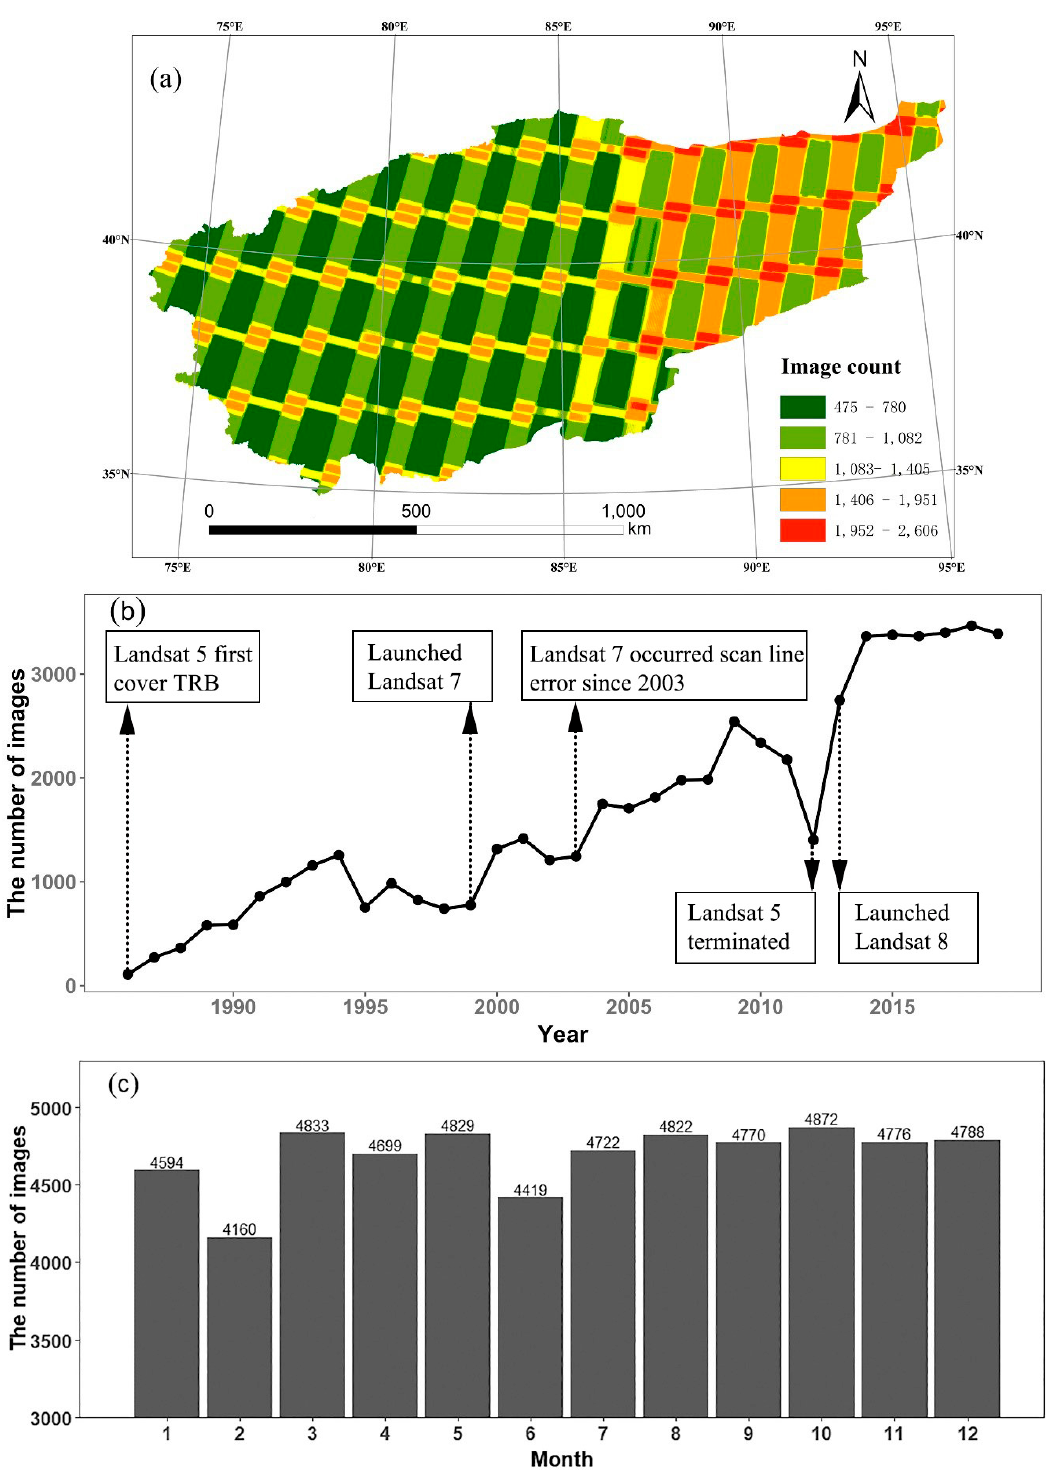
Figure 2. The Landsat image of the study area: ( a ) the spatial distribution, ( b ) temporal distribution, and ( c ) seasonal